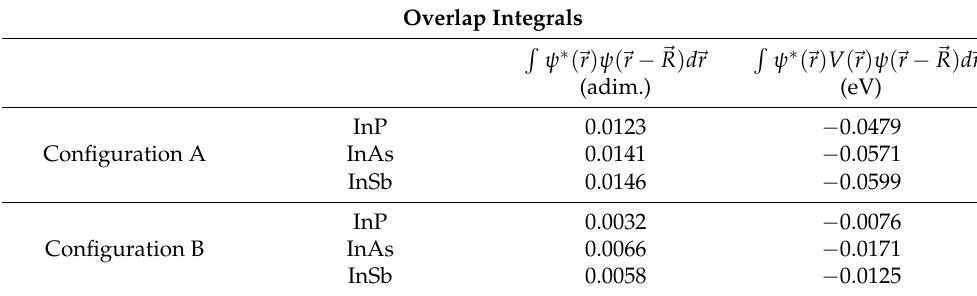
Table 1. Overlap integrals between neighbouring QDs for CBM states. The integral on the left quantifies the confinement of the wavefunction in the QD, whereas the integral on the right is related to the miniband